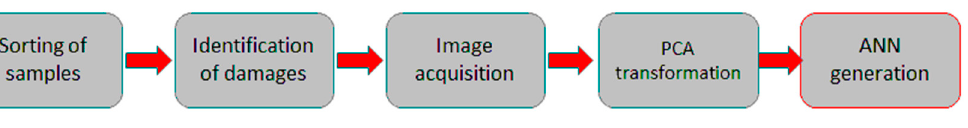
Figure 1. The scheme of the proposed procedures.